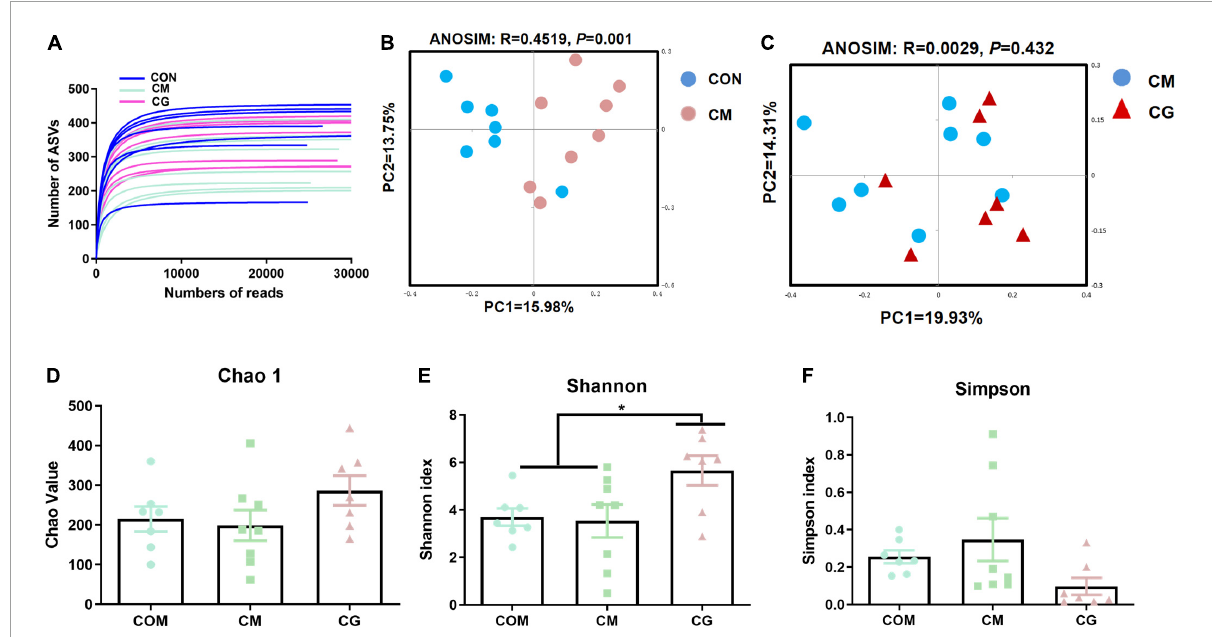
FIGURE6 Effects of low-grain fed (CON), maize meal high-grain fed (CM), and whole maize high-grain fed (CG) on the diversity of colonic mucosal bacterial structures. (A) Bacterial dilution curve of colonic mucosal bacterial community. Horizontal coordinate: the amount of randomly selected sequencing data; vertical coordinate: the number of observed amplicon sequence variants (ASVs). (B) Unweighted UniFrac principal coordinate analysis (PCoA) of bacterial communities in the colonic mucosa between the CON and CM. (C) Unweighted UniFrac principal coordinate analysis (PCoA) of bacterial communities between the CM and CG. Effects of the CON, CM, and CG on the diversity of colonic mucosal bacterial community: Chao1 (D) , Shannon (E) , Simpson (F) . * P < 0.05 indicated that mean values were significantly